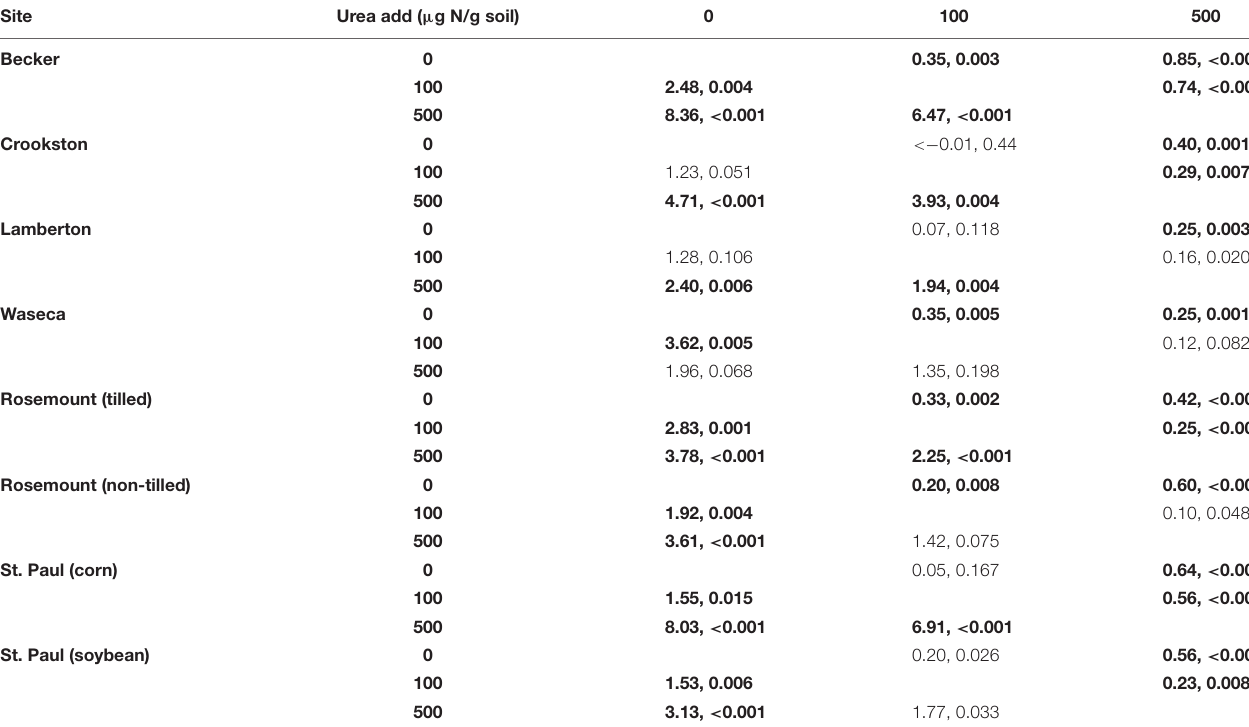
TABLE 2 | Beta diversity statistics relating communities by urea treatment at each sampling site.